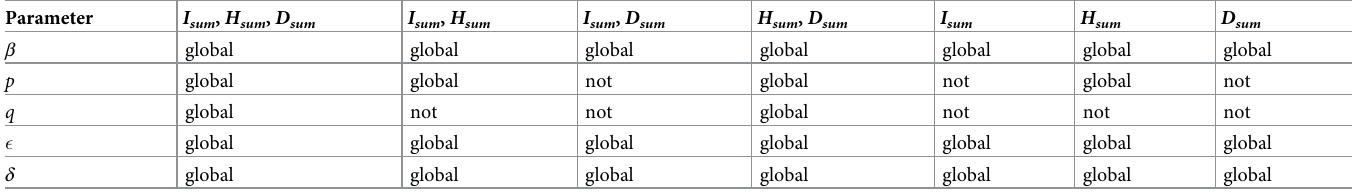
Table 3. Structural identifiability of β , p , q , � , δ with different observables. Global/not means structurally globally/not identifiable, respectively. We fix all the rest of the parameters as in Table 2. We fix the initial condition of each state variable as in Table 1.